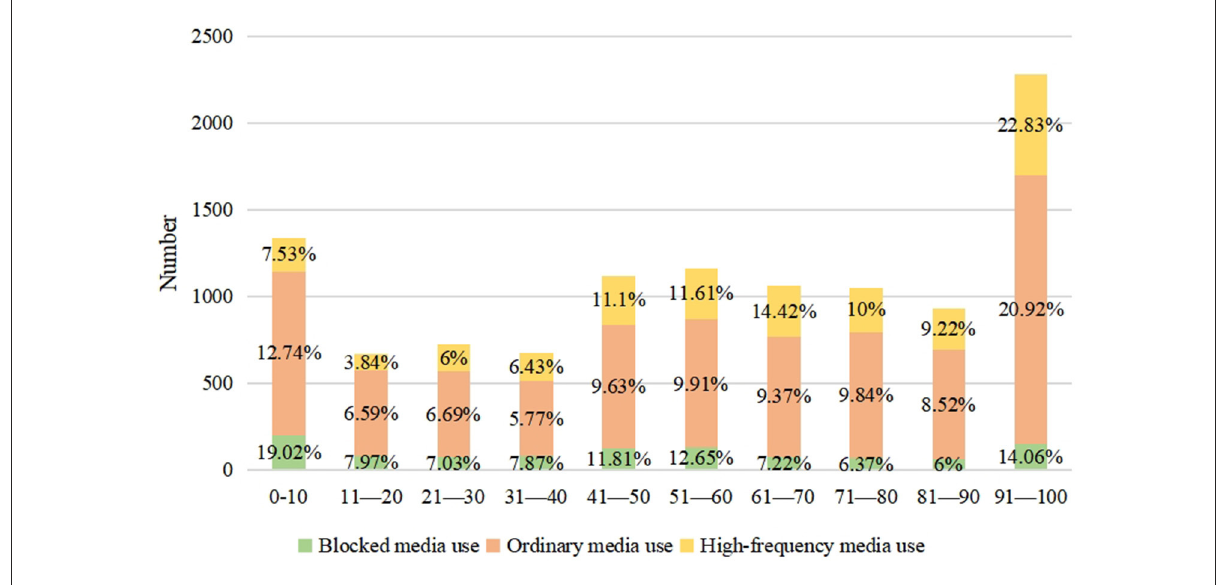
FIGURE2 Summary of residents’ willingness to donate